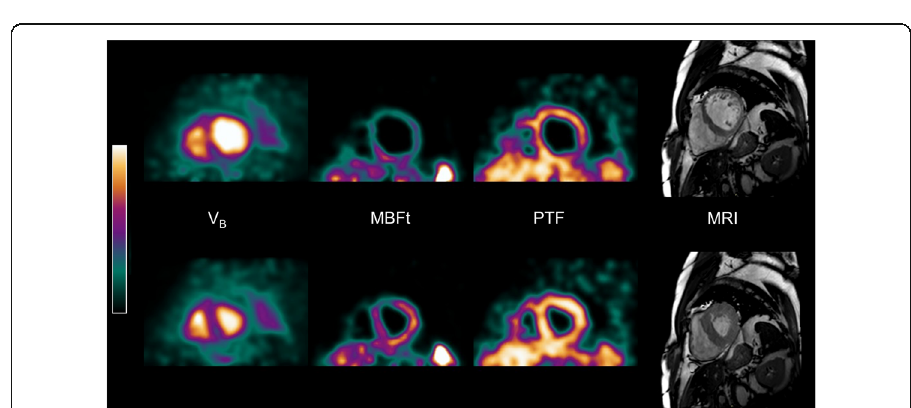
Fig. 1 End-diastolic (top row) and end-systolic (bottom row) short-axis parametric 15 O-water blood volume ( V B ), transmural blood flow (MBFt) and perfusable tissue fraction (PTF) images, as well as MRI images of a typical patient. Colour scales for end-diastolic and end-systolic images are